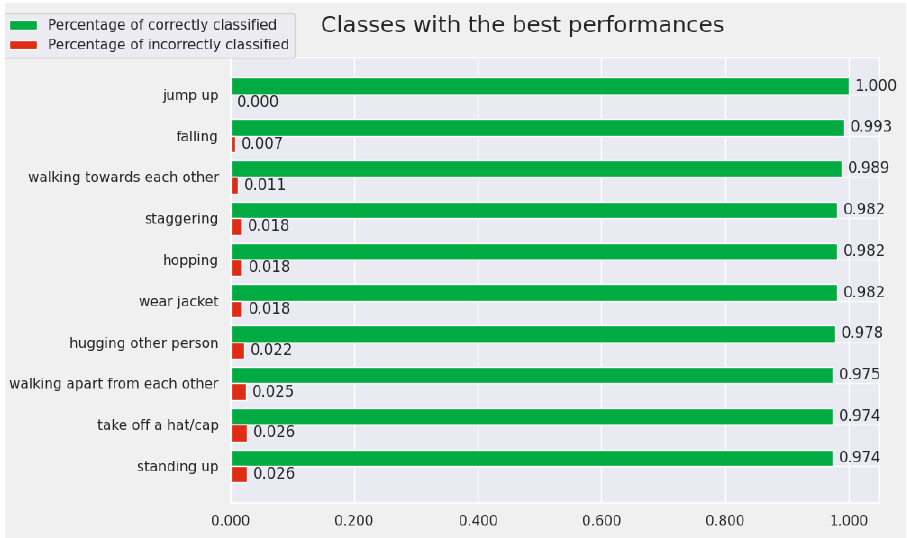
Figure 9. The Top 10 best-recognized classes by the proposed model (from the perspective of Cross- Subject